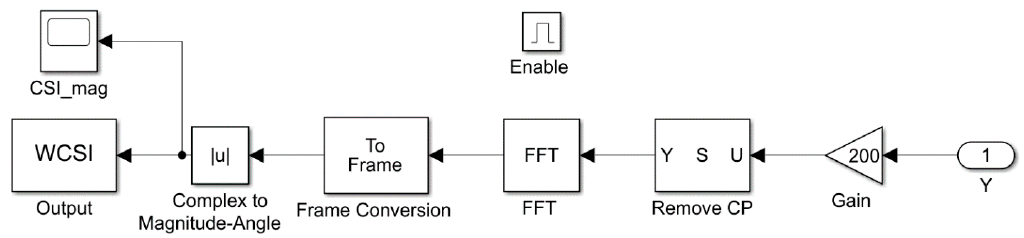
Figure 4. Receiver operation for extracting